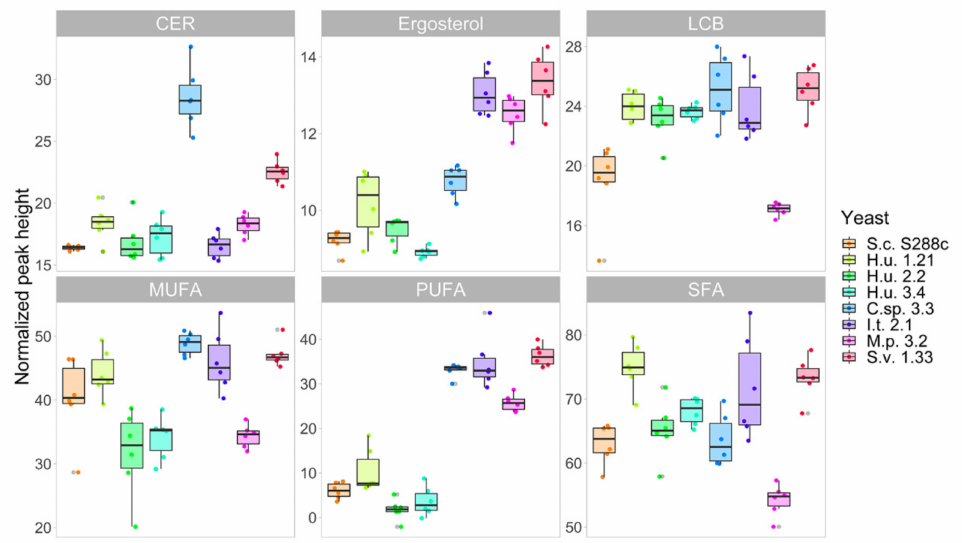
Figure 4. Boxplot of total ceramides (Cer), ergosterol, long-chain base (LCB), monounsaturated fatty acids (MUFA), polyunsaturated fatty acids (PUFA), and saturated fatty acids (SFA) in the eight yeasts included in the study (n =